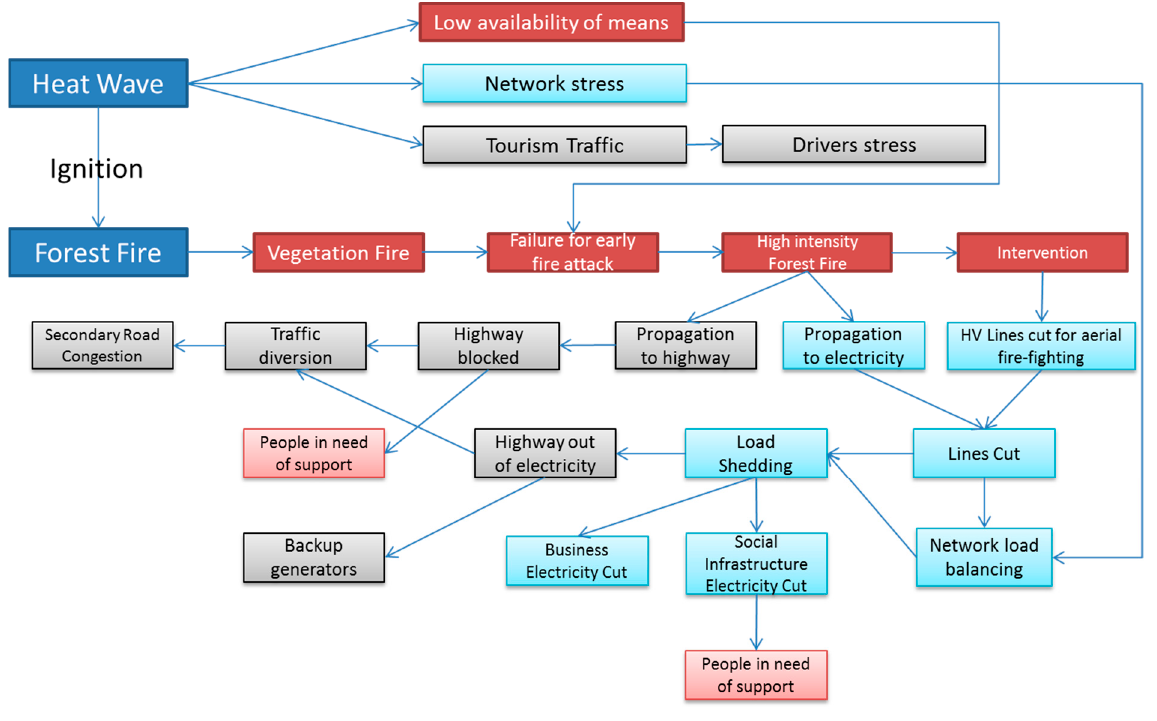
Figure 10. Scenario identified impacts and cascading effects.